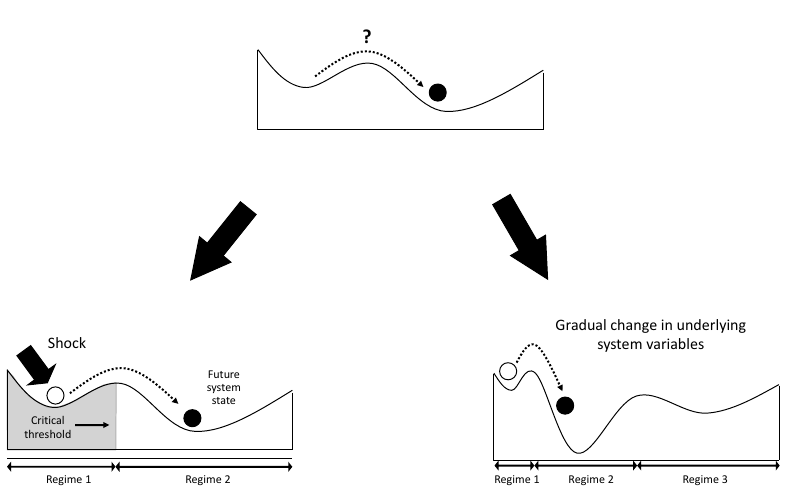
Figure 1. Regime shifts often result from a combination of slow ongoing gradual changes and an external shock to the system that tips the system into an alternative state (Adapted from [19]).